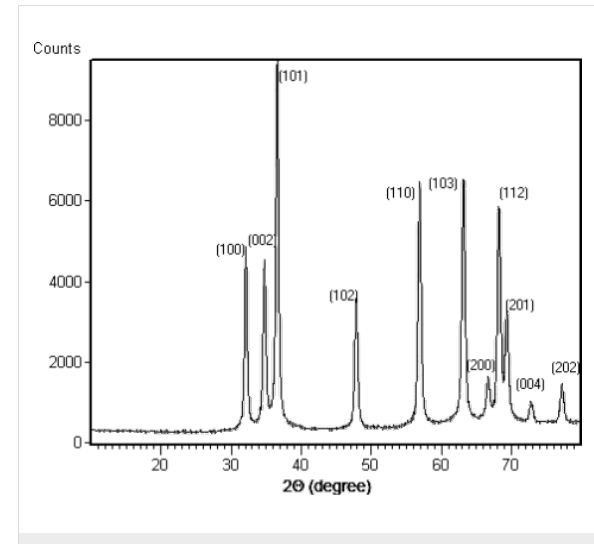
Figure 4: Typical powder diffraction pattern of ZnO/PVP